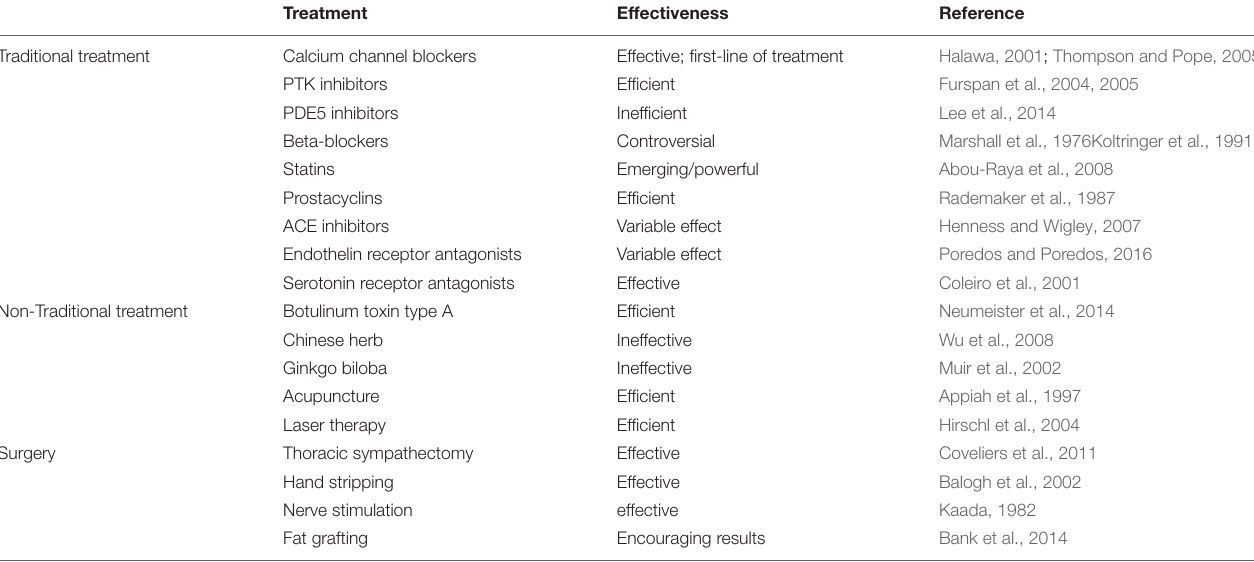
TABLE 1 | Various lines of treatment of Raynaud’s